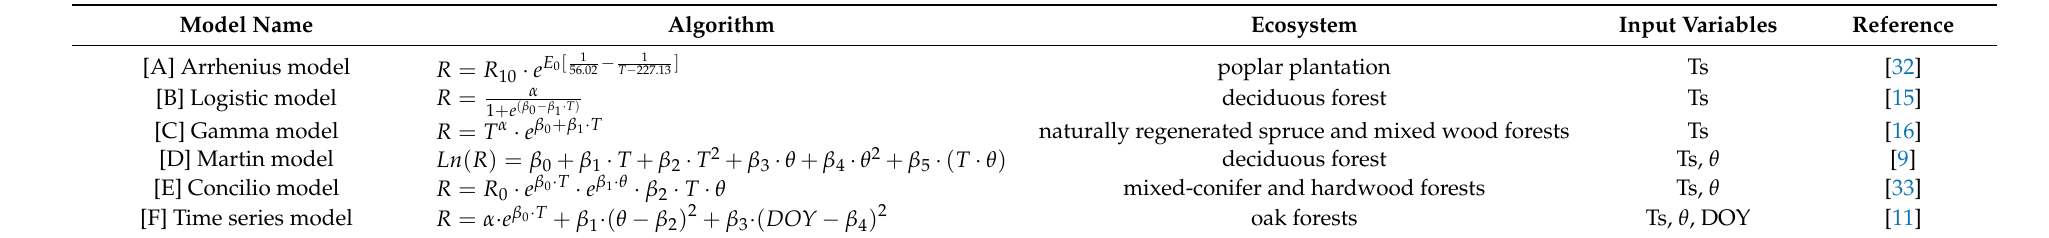
Table 1. Respiration models used in this study, including Arrhenius, logistic, Gamma, Martin, Concilio and time series models. R , ecosystem respiration in